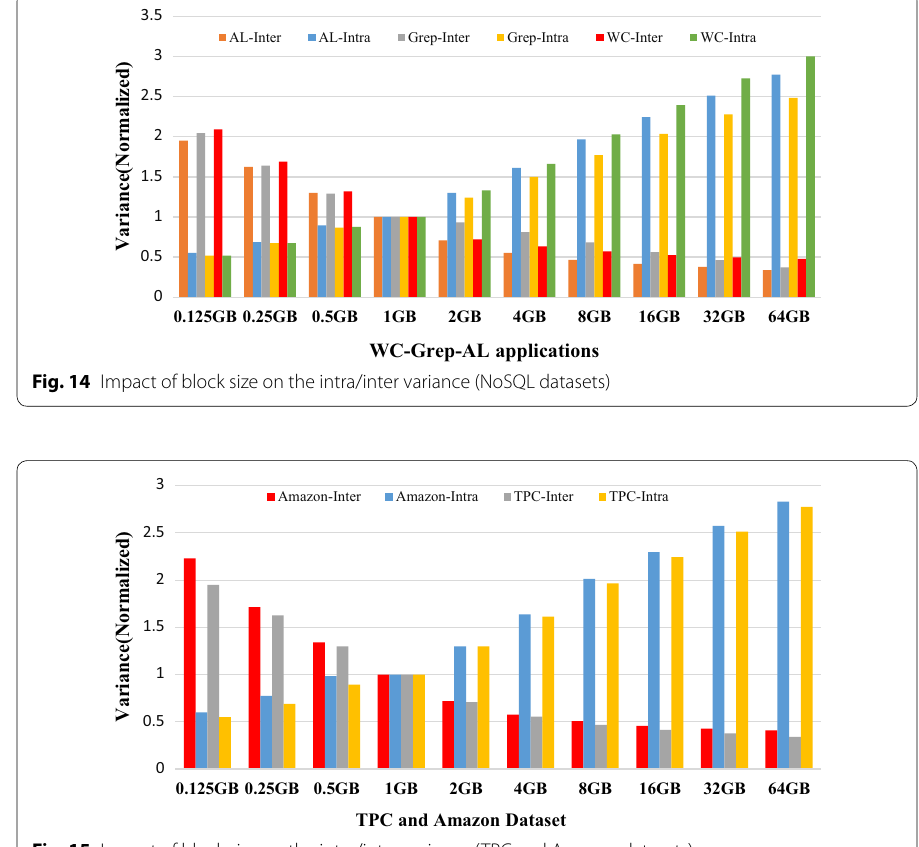
Fig. 15 Impact of block size on the intra/inter variance (TPC and Amazon